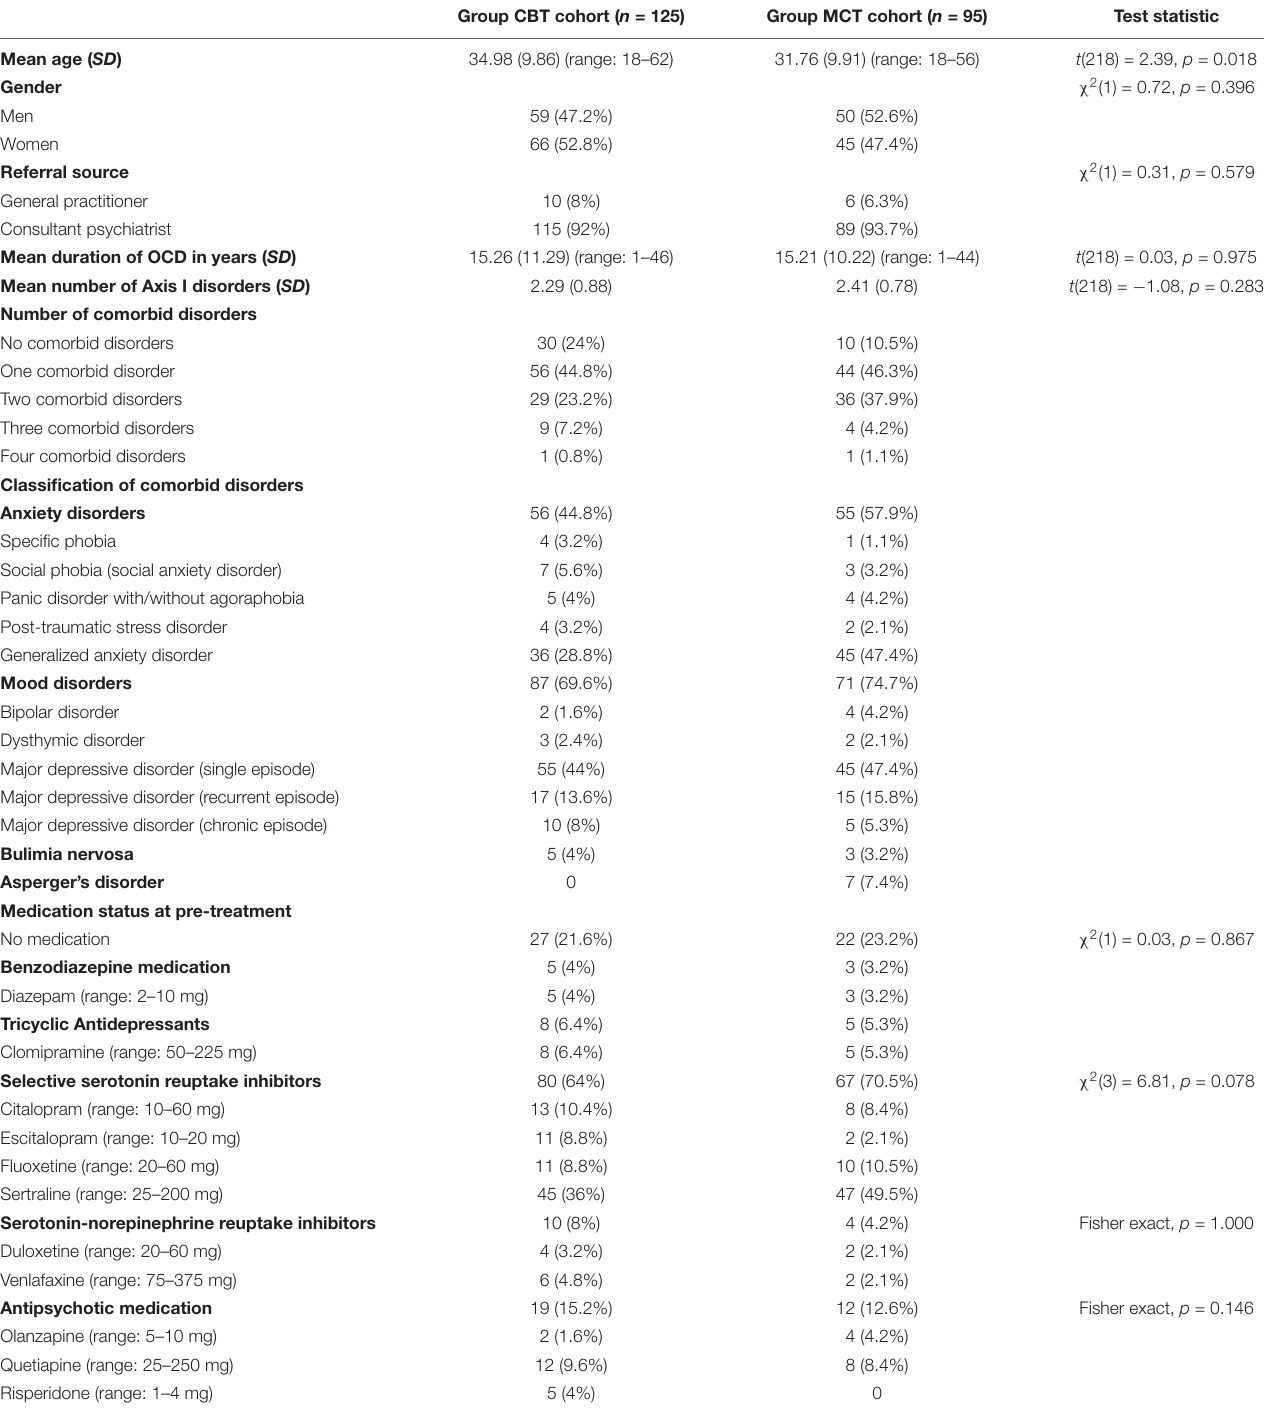
TABLE 1 | Demographic and clinical characteristics of group treatment cohorts. Group CBT cohort ( n = 125) Group MCT cohort ( n =